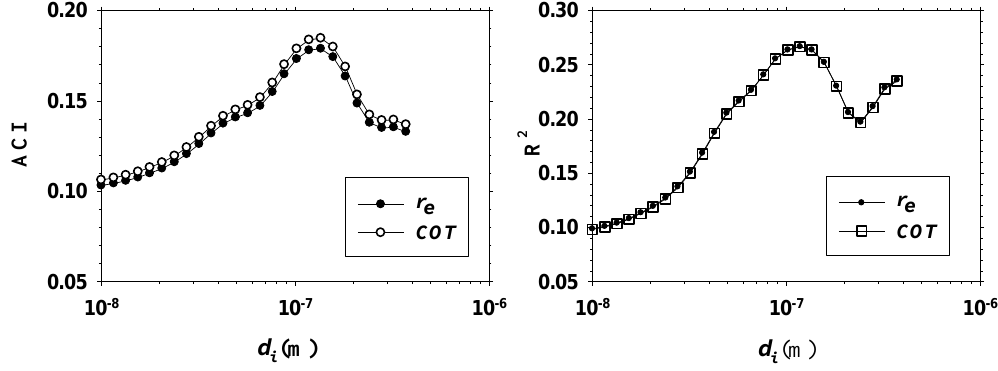
Fig. 3. On the left: Aerosol-cloud interaction (ACI) from a combination of remote sensing cloud properties and in situ measures of aerosol burden as a function of particle size. On the right: correlation coefficient ( R 2 ) between cloud and aerosol parameters as a function of particle size.